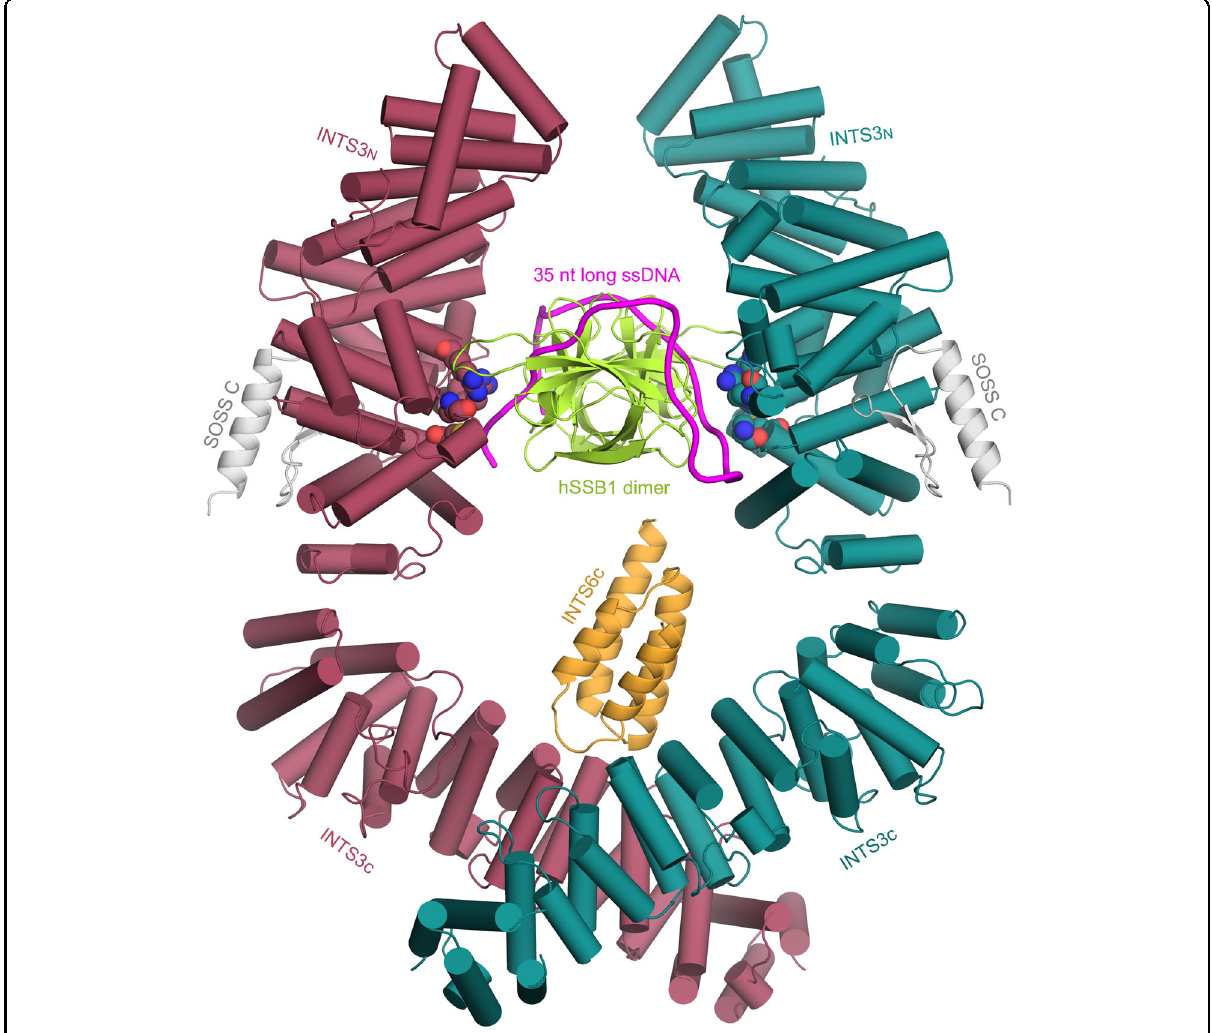
Fig. 6 The model of INTS3/hSSB1/SOSSC/INTS6c interacting with 35-nt long ssDNA. The color coding for INTS3 and INTS6c is the same as in Fig. 1. SOSSC and SSB1 are shown in light gray and lemon, respectively, while ssDNA is shown in magenta. The residues that were previously observed to contact ssDNA in the structure of INTS3 N /SSB1/SOSSC are shown in space- fi lling